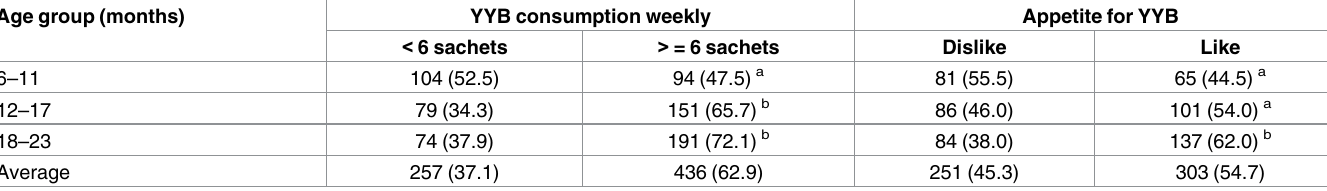
Table 3. Yingyangbao consumption weekly by children of different age groups [N(%)].